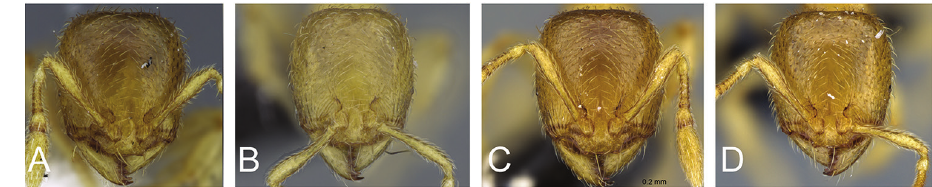
Hairs of the scape, posterior margin and lateral margins of head, abundant and subdecumbent; dorsum of promesonotum with abundant short suberect hairs (20–30 hairs); distance from center of the propodeal spiracle to declivity same or slightly longer than the diameter of the spiracle (Fig. 27A) ........... C. salegi – Hairs of the scape, posterior margin and lateral margins of head, decumbent or appressed; dorsum of promesonotum with short subdecumbent to suberect hairs (fewer than 20 hairs); distance from center of the propodeal spiracle to declivity less than the diameter of the spiracle (Fig. 27B, C, D) ..................... 14